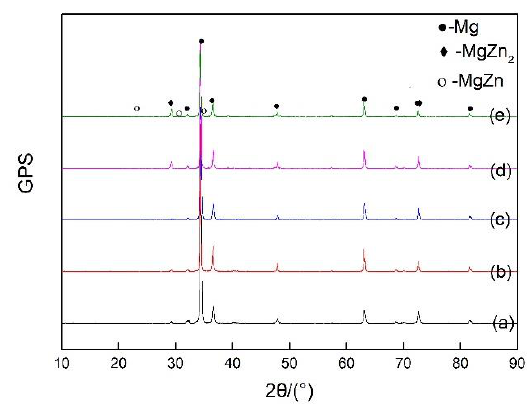
Figure 6. XRD pattern of the HSRR ZK60 magnesium alloy under different strain rates ( a ) 5 s −1 ( b ) 10 s −1 ( c) 15 s −1 ( d ) 20 s −1 ( e ) 25 s −1 .